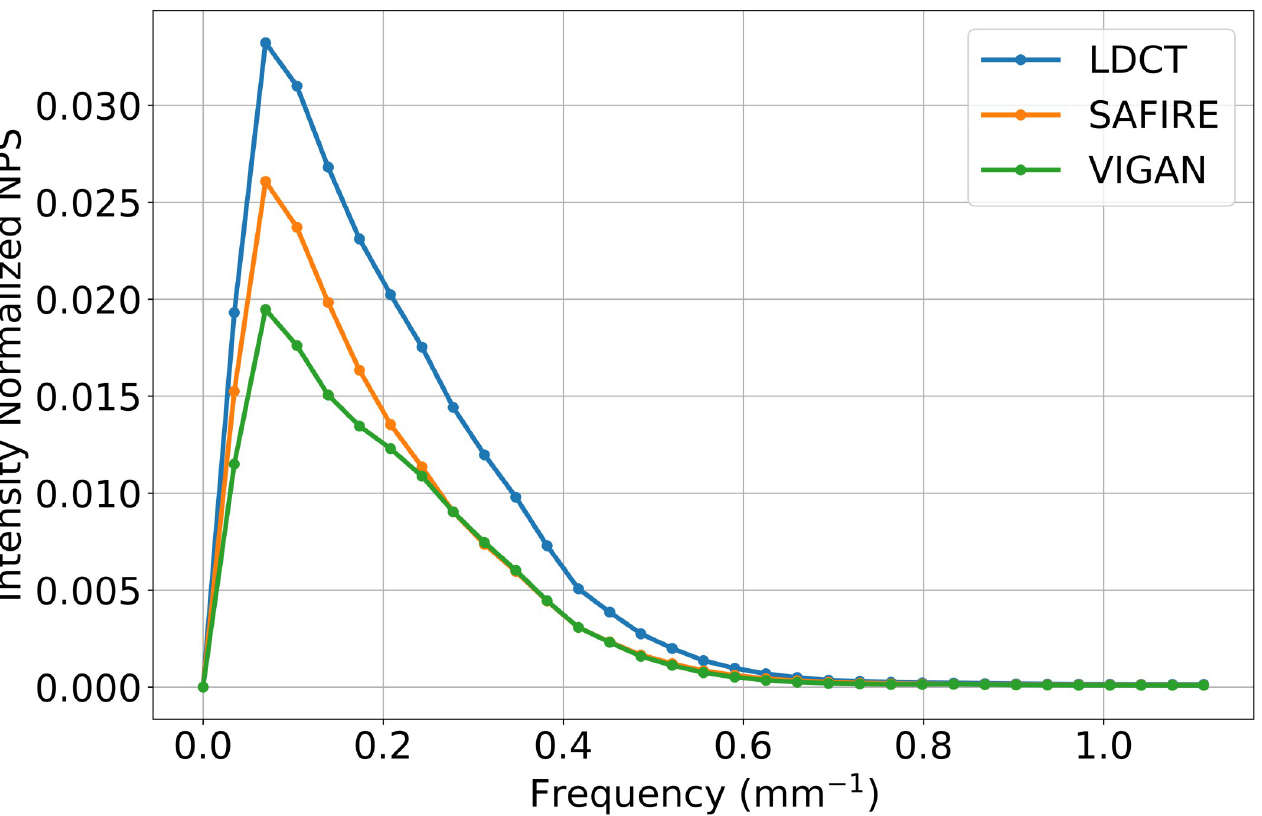
Fig 7. Comparison of intensity normalized NPS curves among original LDCT, SAFIRE, and VIGAN.